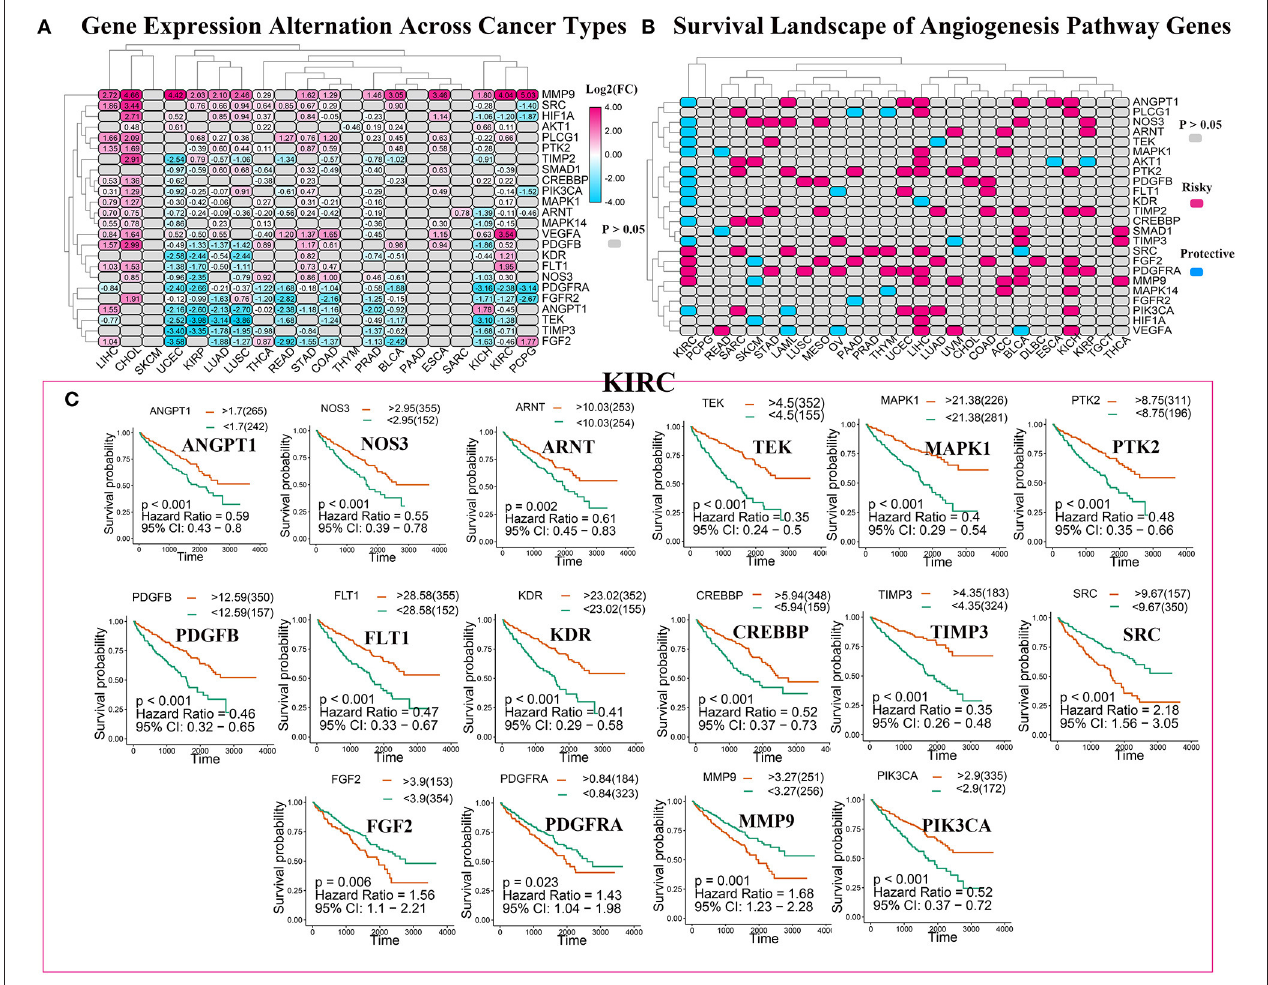
FIGURE 3 | The roles of angiogenesis pathway genes in cancer. (A) The changes in the expression of 24 angiogenesis pathway genes among 32 tumor types. The color code bar on the right side shows the corresponding value of log2(FC). And negative changes are displayed in blue, and positive changes are displayed in red. The P > 0.05 indicates no statistical significance and is displayed in gray. (B) Heatmap showed the survival landscape of angiogenesis pathway genes. Blue represents the protective genes and red represents risky genes. The gray bar represents no statistical significance. (C) The survival curve of angiogenesis pathway genes in kidney renal clear cell carcinoma (KIRC). We divided the genes into the high-expression and low-expression groups based on the best cut-off values using the “survminer” package and then plotted the survival curve. The orange line represents the high-expression groups; the green line represents the low-expression groups. The abscissa represents the number of days, and the ordinate represents the survival